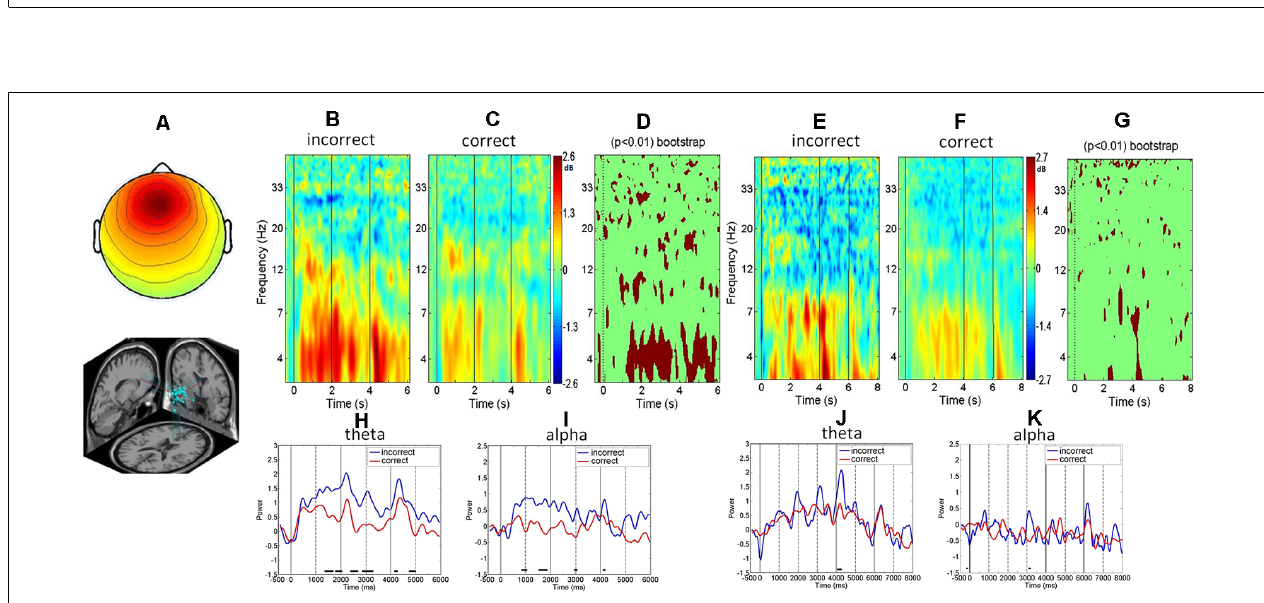
FIGURE 3 | The frontal midline clusters. (A) Scalp map and dipole location. (B,C) ERSP’s comparison between the incorrect and correct responses to picture trials. (D) The bootstrap statistics indicating significant ( p < 0.01) power changes between the incorrect and correct responses for the picture trials. (E,F) ERSP’s comparison between the incorrect and correct responses for the word trials. (G) The bootstrap statistics indicating significant ( p < 0.01) power changes between the incorrect and correct responses for word trials. (H,I) Mean spectral comparison between the incorrect and correct responses in the theta band and alpha band; blue represents the incorrect response, red means the correct response for picture trial. (J,K) Mean spectral comparison between the incorrect and correct responses in the theta band and alpha band; blue represents the mean power of incorrect responses, red represents the mean power of correct response for the word trials. Note: subplots (H–K) miss the bottom part of the figure and X-tick labels.